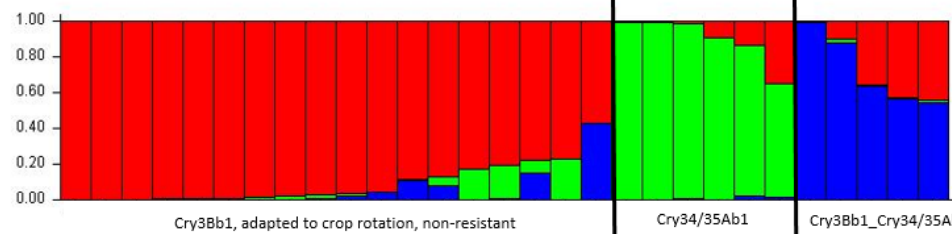
Figure 4. Determination of the optimal value of K = 3 and population structure of 29 WCR genotypes using DArTseq SNP markers.